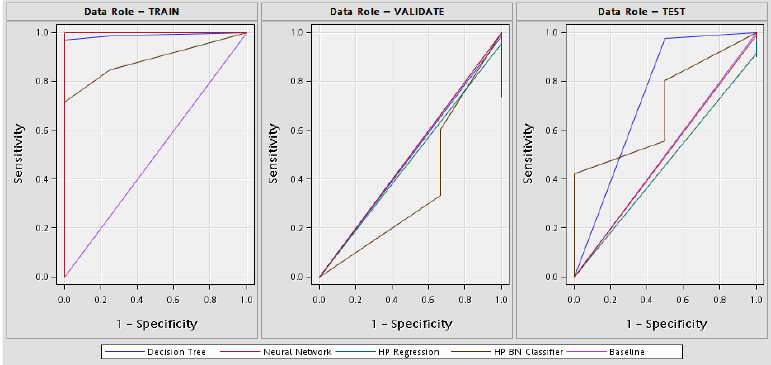
Figure 19. ROC curve comparison